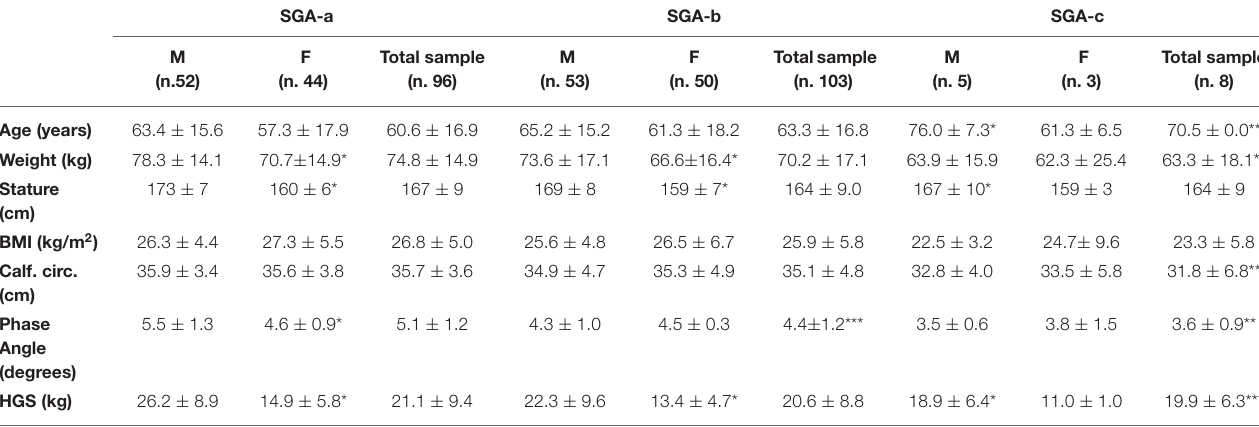
TABLE 4 | Anthropometric characteristics, handgrip strength and body composition according to SGA score in males, females and total sample. SGA-a SGA-b SGA-c M F Total sample (n.52) (n. 44) (n.